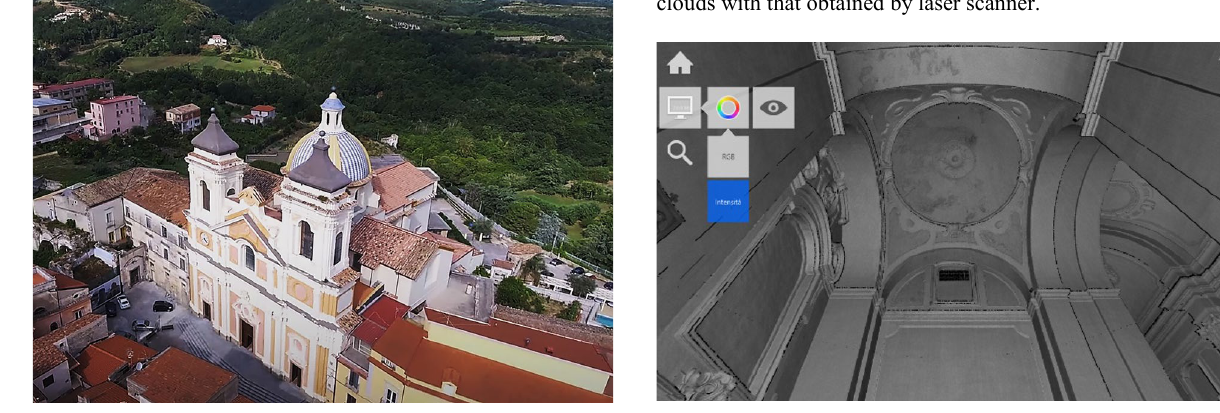
Figure 1. Chiesa dell’Annunziata, UAV photo Figure 2. Intensity visualization mode in ReCap